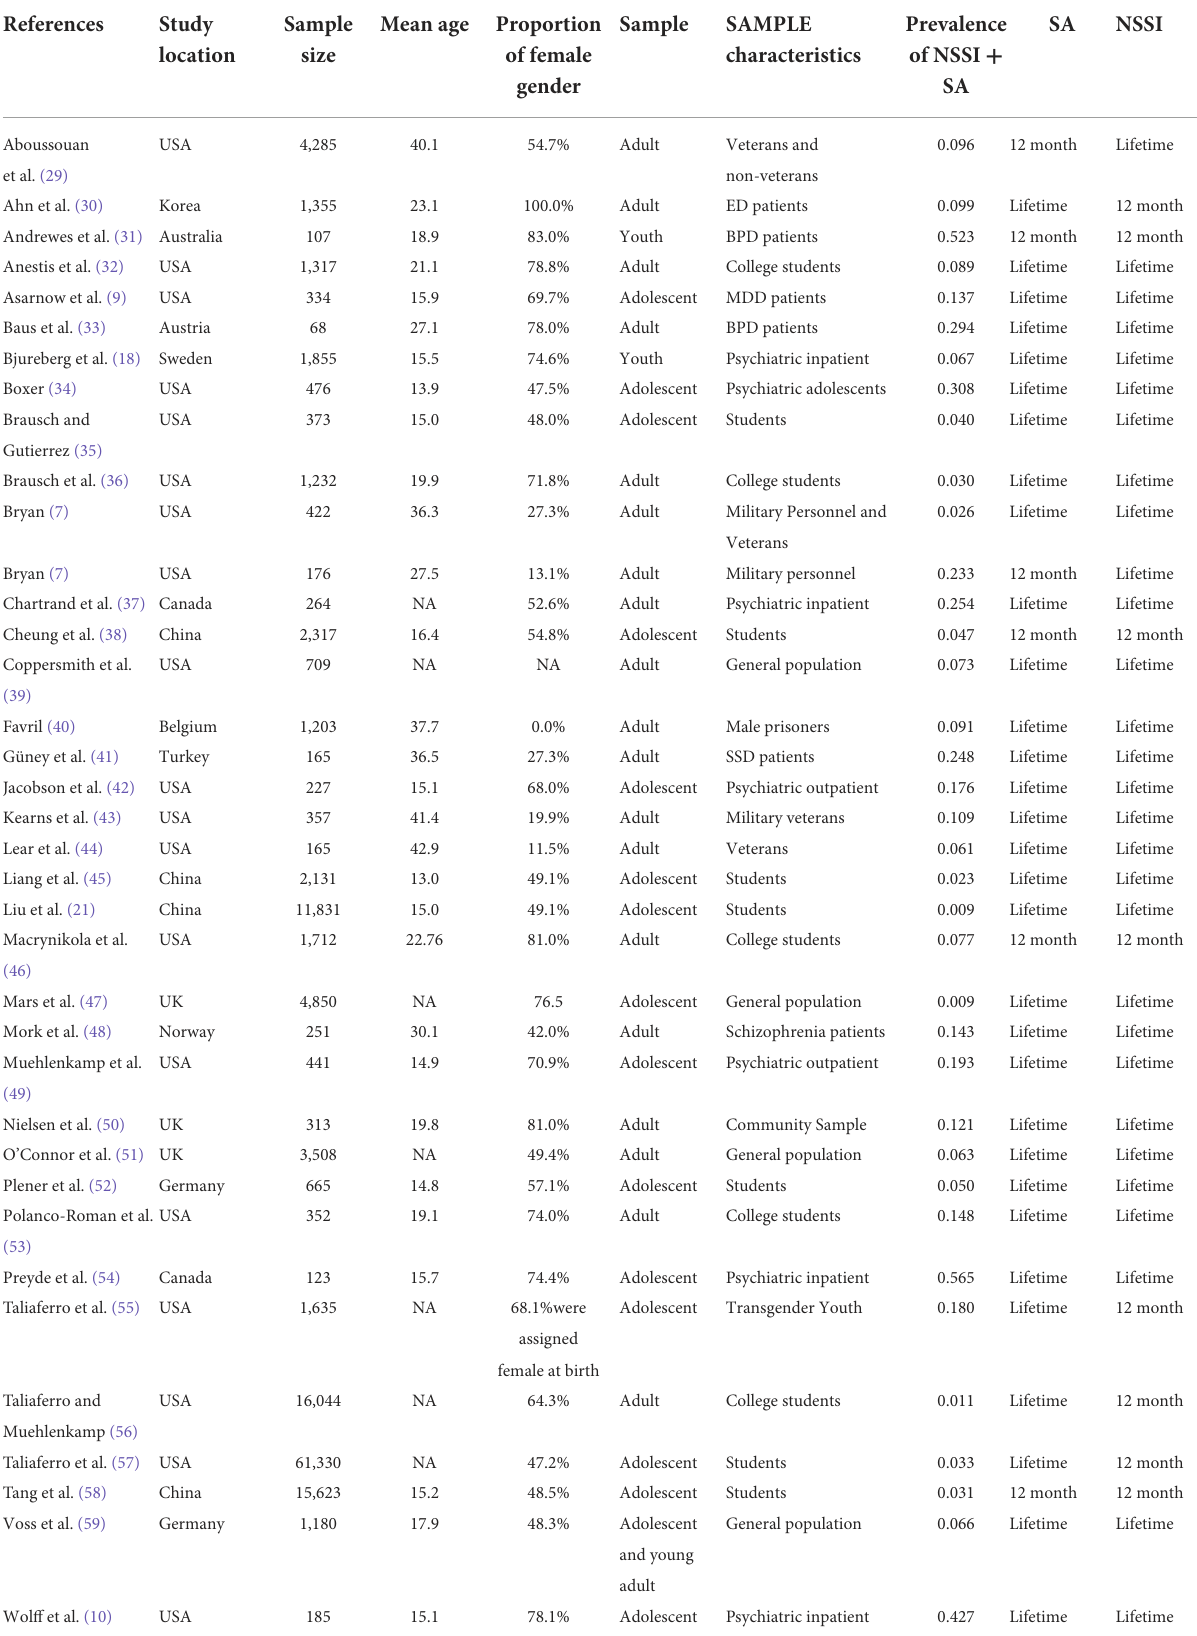
TABLE 1 Characteristics of the included